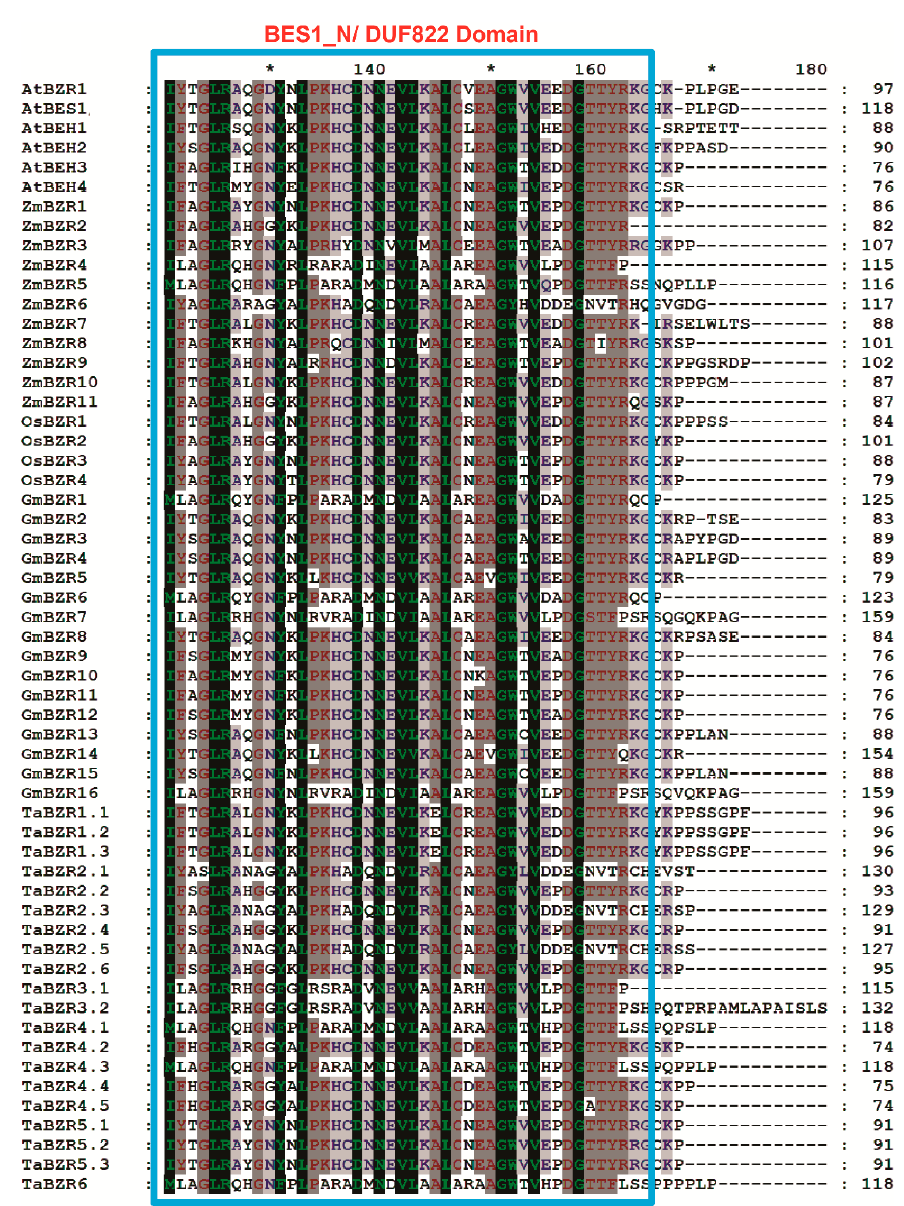
Figure 6. Alignment of the TaBZR with other plant species BZR protein sequences. Deduced amino sequence of TaBZR was aligned with BZR proteins from Arabidopsis thailiana , Zea mays , Oryza sativa , and Glycine max . The conserved BES_N1.DUF822 domain is boxed with light blue color. Colored and shaded amino acids are chemically similar residues. Dashes indicate gaps introduced to maximize the alignment of the homologous region. * indicates positions which have a single, fully conserved residue.